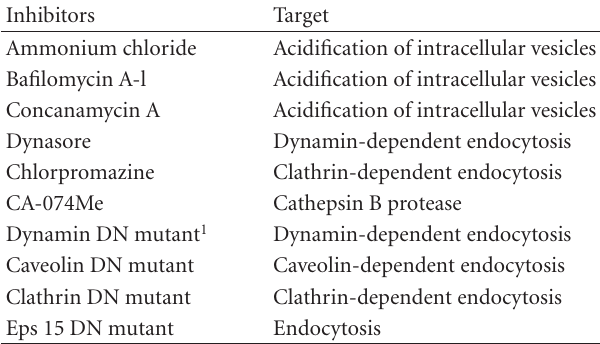
Table 1: Inhibitors used in studies of retroviral entry pathway.